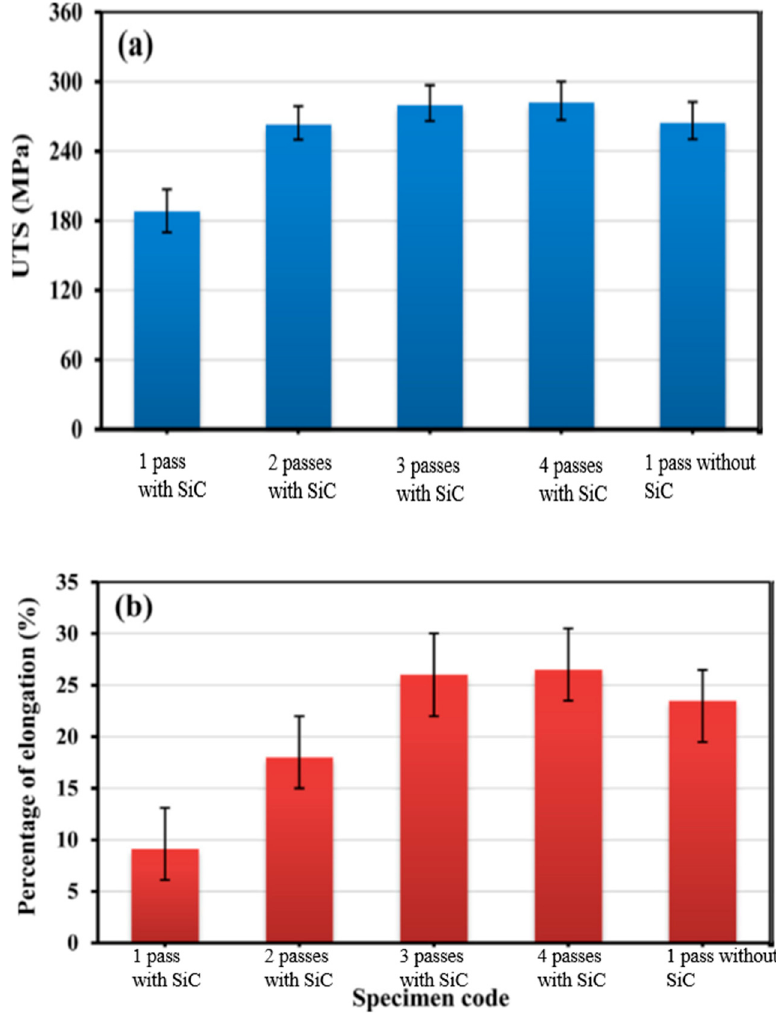
Figure 5. Mechanical properties of ( a ) tensile strength and ( b ) elongation in Friction stir welding (FSW) joints with SiC reinforcement [51] . (FSW) joints with SiC reinforcement